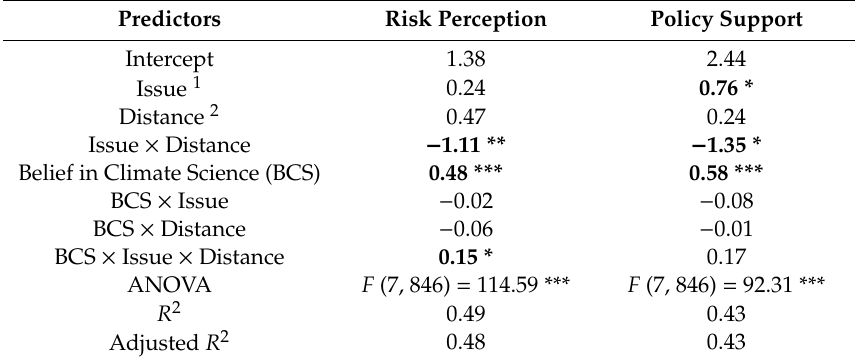
Table 3. Regression models predicting risk perception and policy support with message frames, belief in climate science and their interaction (unstandardized regression coe ffi cients).